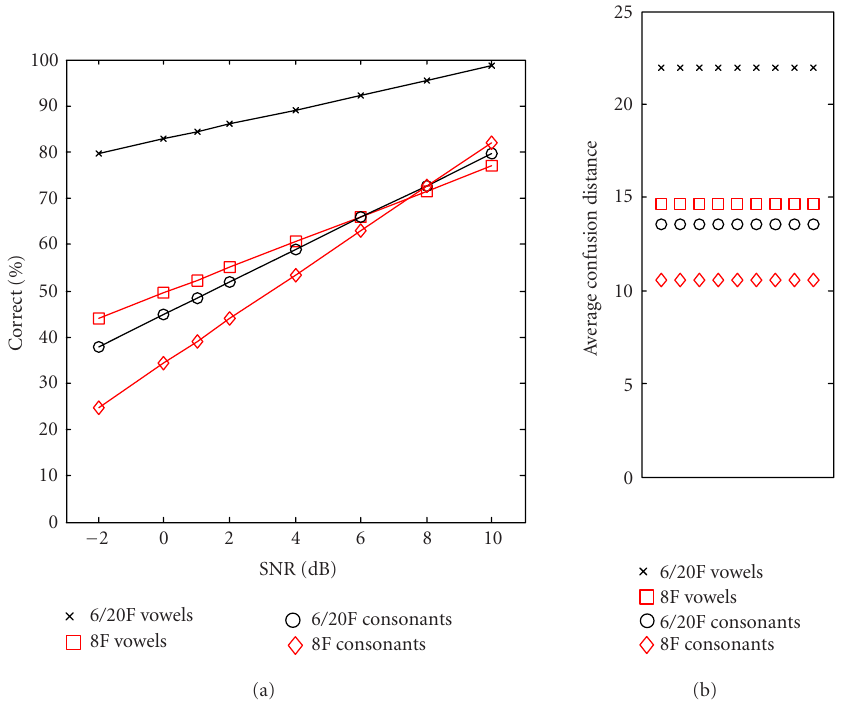
Figure 7: (a) Trends in results of the listening tests separated by model and test material. (b) Trends predicted by DTW using average confusion